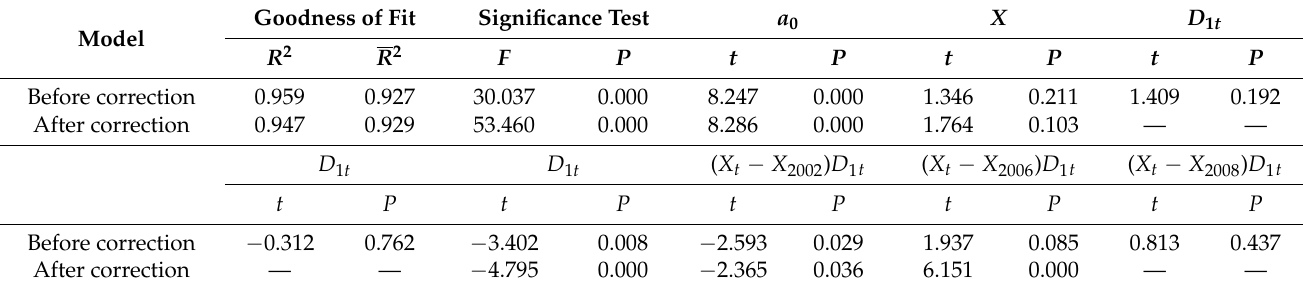
Table 1. Comparison of the goodness of fit and significance test results before and after model adjustment.